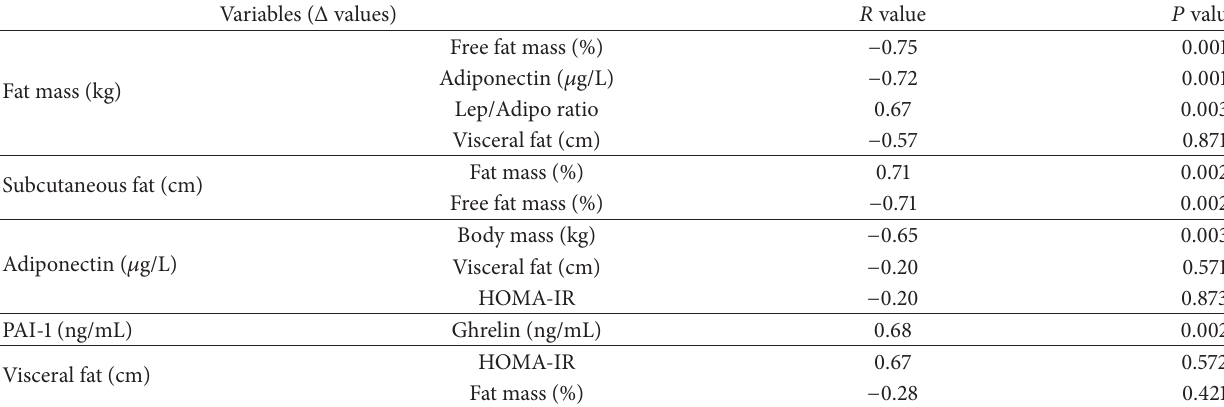
Table 5: Correlations